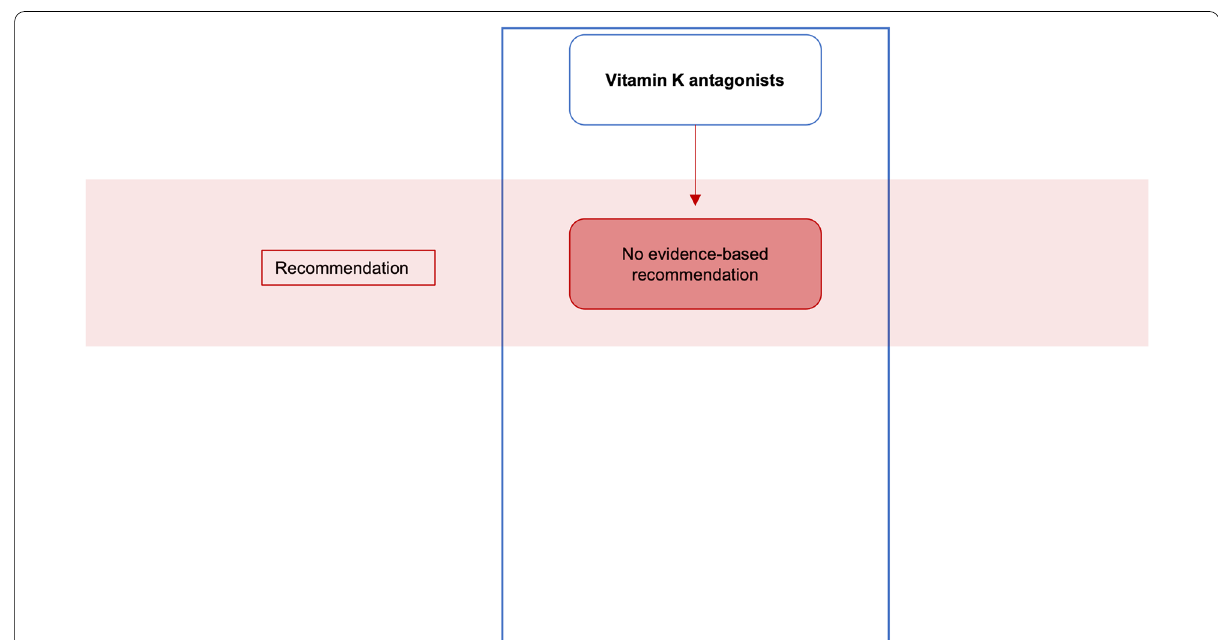
Fig. 5 Clinical recommendations for oral surgery in patients treated with vitamin K